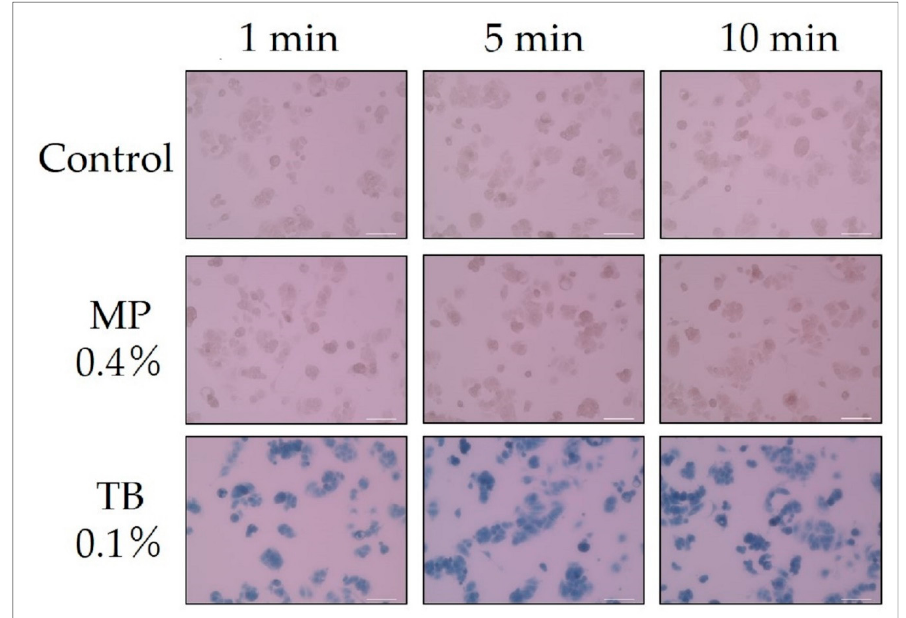
Figure 3. Immersion time and staining of dead cells (microwave treatment). All scale bars designate 100 μ m.